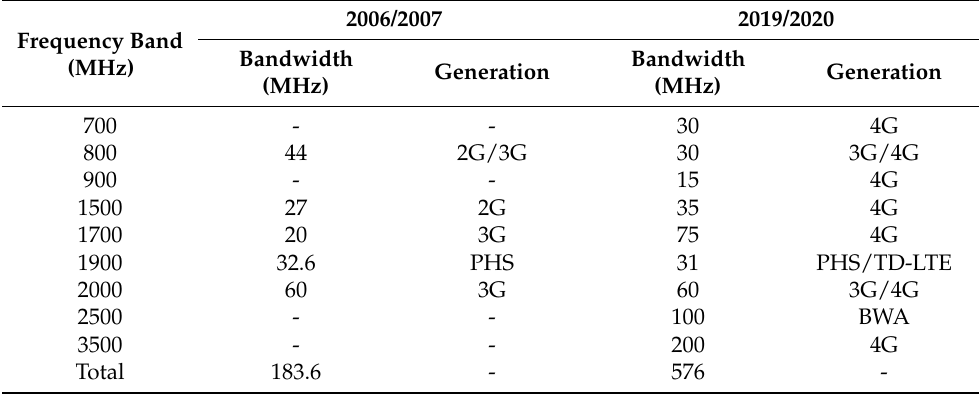
Table 3. Frequency and bandwidth of mobile phone systems except for